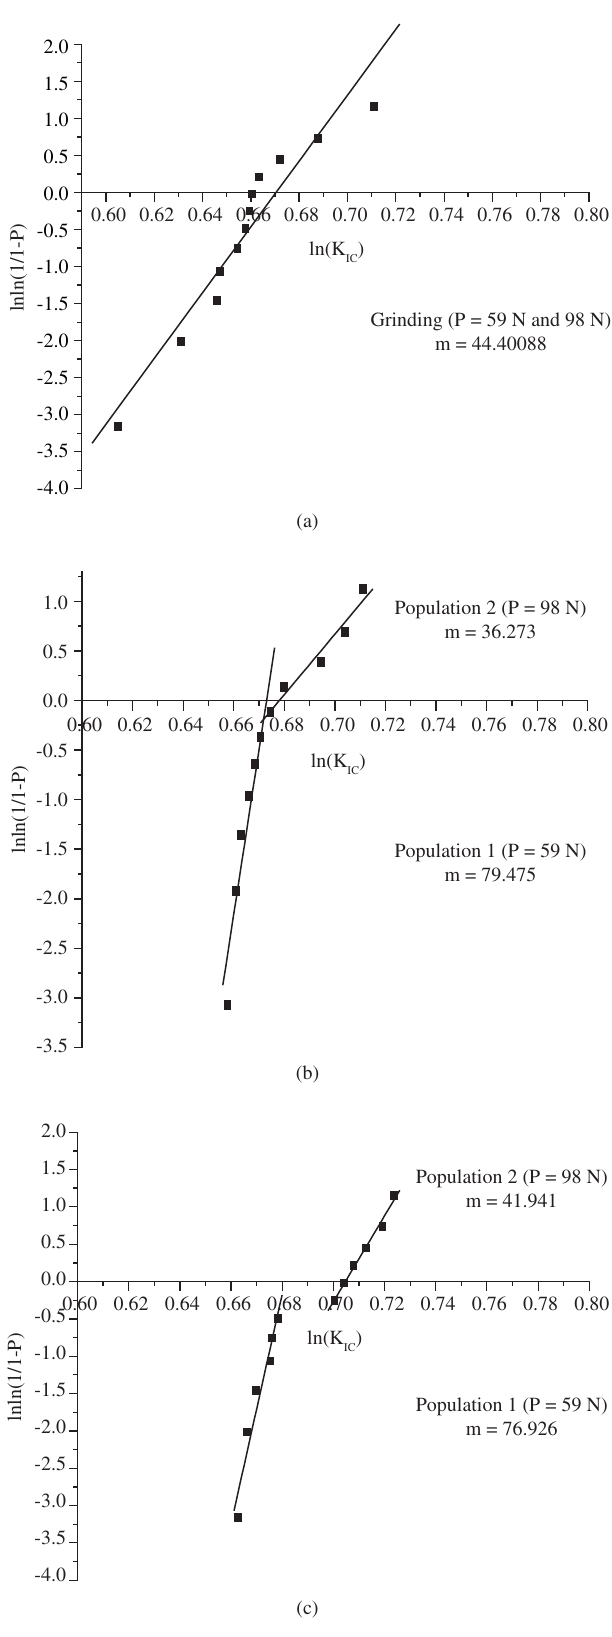
Figure 3. Weibull distribution of fracture toughness by indentation strength ( IS ) of the ZTA disks submitted to the three different mechanical surface treat- ments: a) grinding; b) sandblasting; c) grinding + sandblasting +